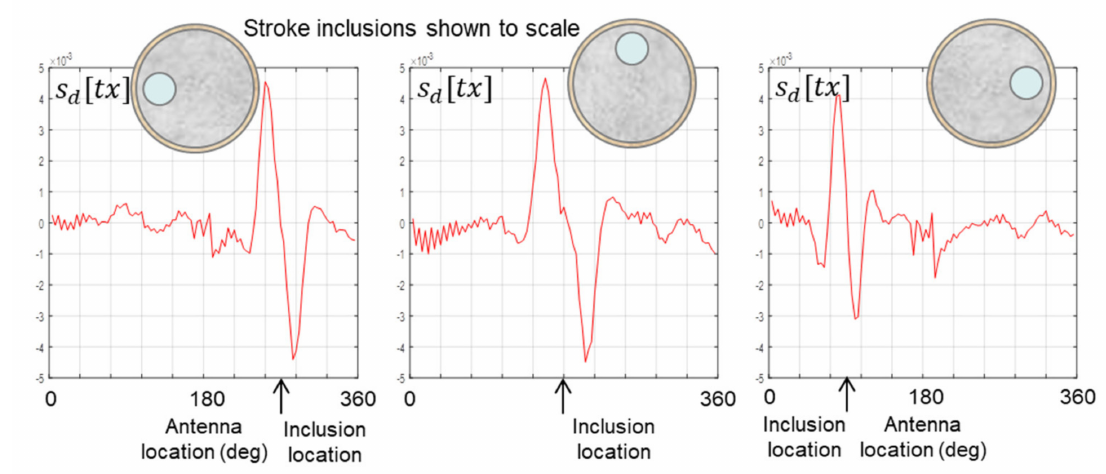
Figure 15. Data from scans in which the 44 mm inclusion is at different locations relative to the start of each